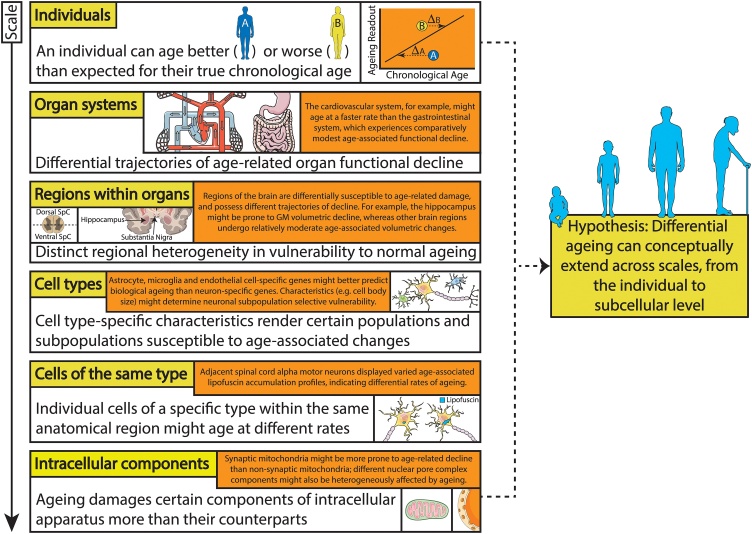
The concept of differential ageing can be applied on an increasingly smaller scale. Differential ageing has been evidenced on an organism level, where an individual can biologically age better or worse than is expected for their chronological age. As well as different individuals ageing differently, ageing affects the function of various organ systems heterogeneously. Moreover, similar principles can be applied to nervous system regions, individual cells and even components within a single cell, which might age disproportionately to their counterparts. Some examples of differential ageing at each scale are provided above, which might have important consequences for age-related disease research. The experimental tractability of analysing nervous system tissue, cellular and molecular differential/delta ageing, as well as its possible future implications therapeutically, are reviewed in the discussion section. GM = grey matter; SpC = spinal cord. Templates used/adapted to create this figure are freely available from Servier Medical Art (https://smart.servier.com/). (References used to create this figure: D’Angelo et al., 2009; Fjell et al., 2013; Jernigan et al., 2001; Khan et al., 2017; Maxwell et al., 2018; Rhinn and Abeliovich, 2017; Soreq et al., 2017; Stauch et al., 2014).